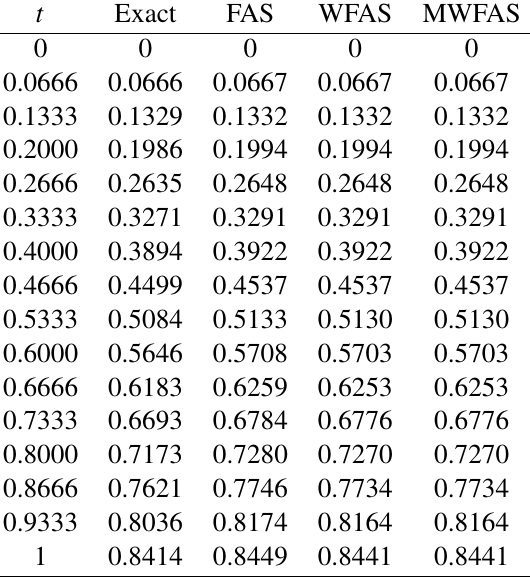
Table 3 Numerical results of test problem 5.2, for N = 16 .